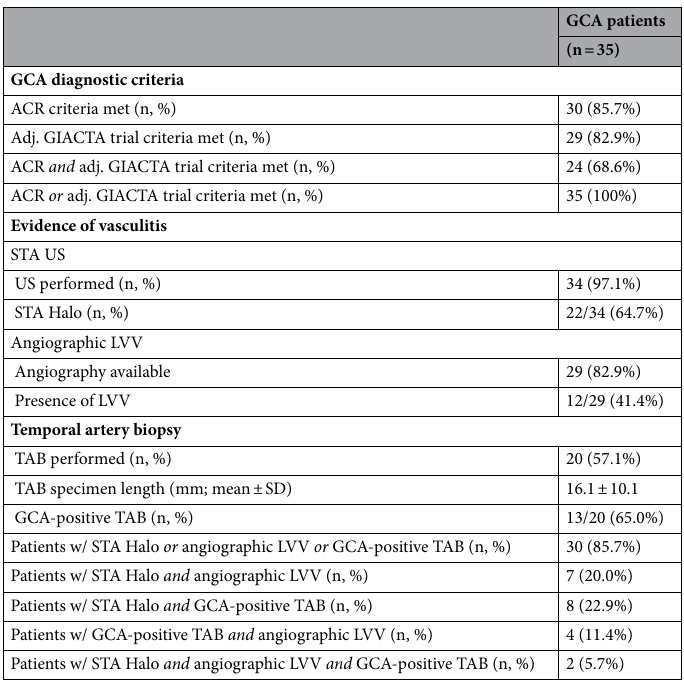
Table 2. GCA patient cohort: diagnostic criteria, TAB, STA ultrasonography and angiography results. ACR american college of rheumatology, adj adjusted, GiACTA trial giant-cell arteritis actemra trial, GCA giant cell arteritis, LVV large vessel vasculitis, STA superficial temporal artery, TAB temporal artery biopsy, US